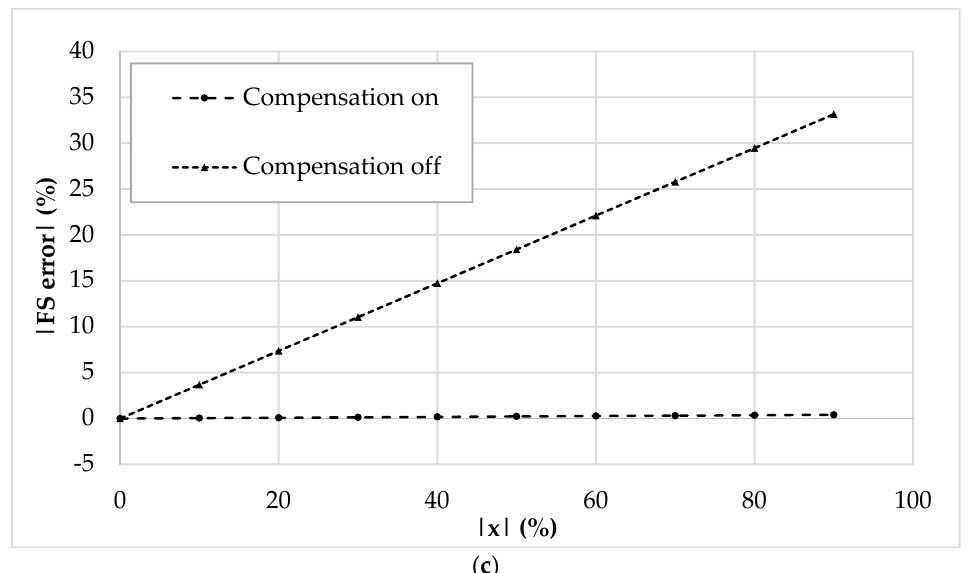
Figure 9. Discrete interface simulations: ( a ) Time domain output voltage, ( b ) extracted DC characteristic, ( c ) full-scale error (%).